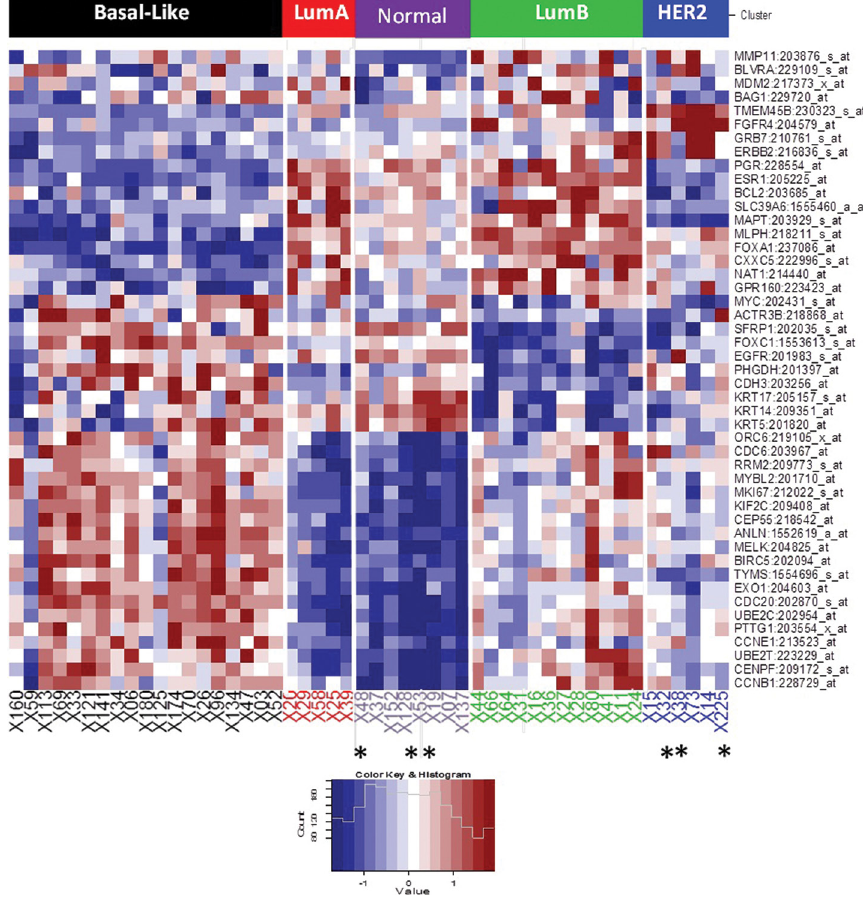
Figure 2. Molecular classification using PAM50 algorithm. Heat map from 50 samples (TNBC and nTNBC). Five different molecular subtypes are at the top of the heat map. Blue represents low gene expression, while red represents high gene expression. In the heat map, each column is for a different patient and each row is for a gene. Asterisk (*) represents TNBC samples according to IHQ analysis that are not in the basal-like